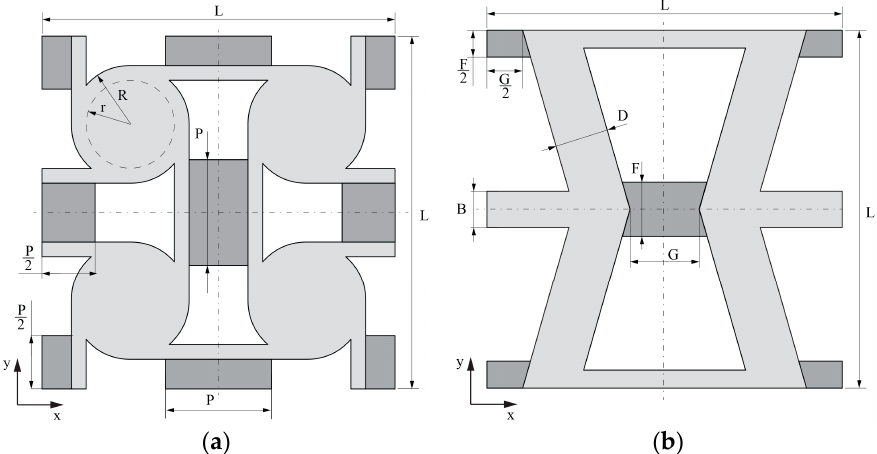
Figure 2. Geometries of analyzed unit cells: ( a ) modified anti-tetrachiral and ( b ) modified re-entrant honeycomb. Additional elements of unit cells in dark gray.